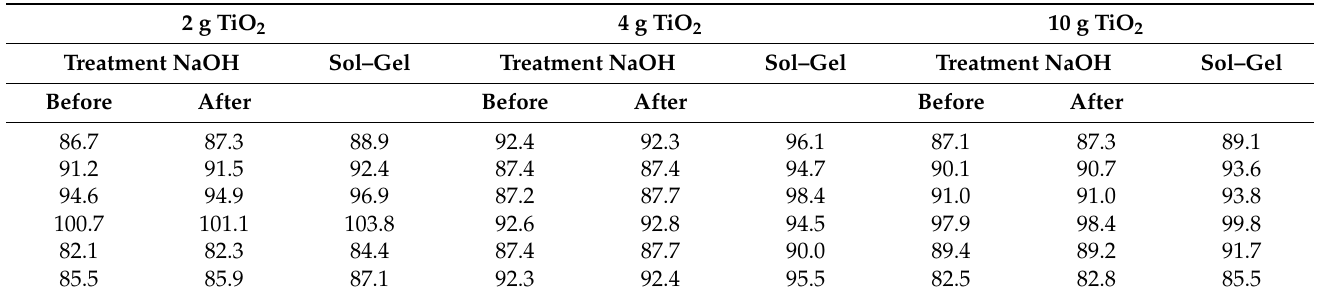
Table 1. Weighing results of samples (g).